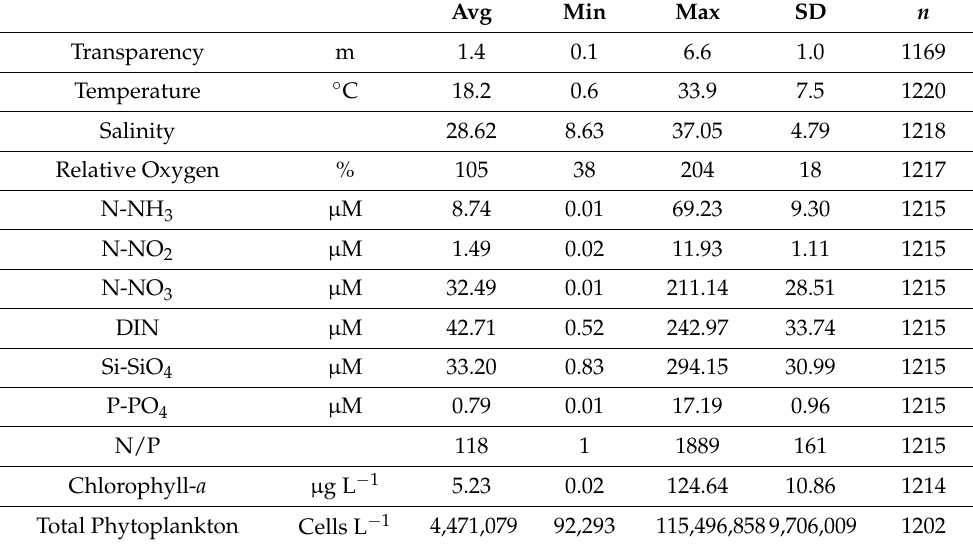
Table 2. Averages (Avg) and standard deviations (SD), minimum (min) and maximum (max) values, and number of observations ( n ) for the main abiotic parameters for the whole study period. Avg